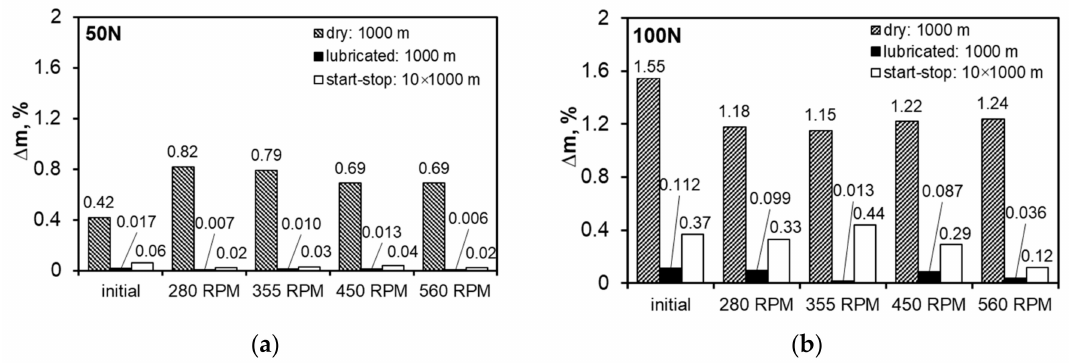
Figure 13. Weight loss: ( a ) determined at load of 50 N, ( b ) determined at load of 100